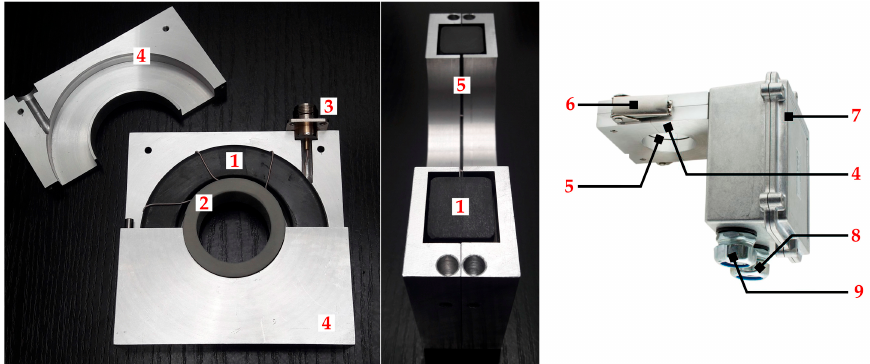
Figure 13. The components of sensor ISO-002-HF: 1 = MnZn ferrite core with secondary winding, 2 = insulation, 3 = N-type connector, 4 = high-frequency current transformer (HFCT) sensor housing, 5 = slit in metallic housing, 6 = adjustable latch, 7 = waterproof enclosure for electronics, 8 = cable gland for power supply, 9 = fiber optic cable gland.